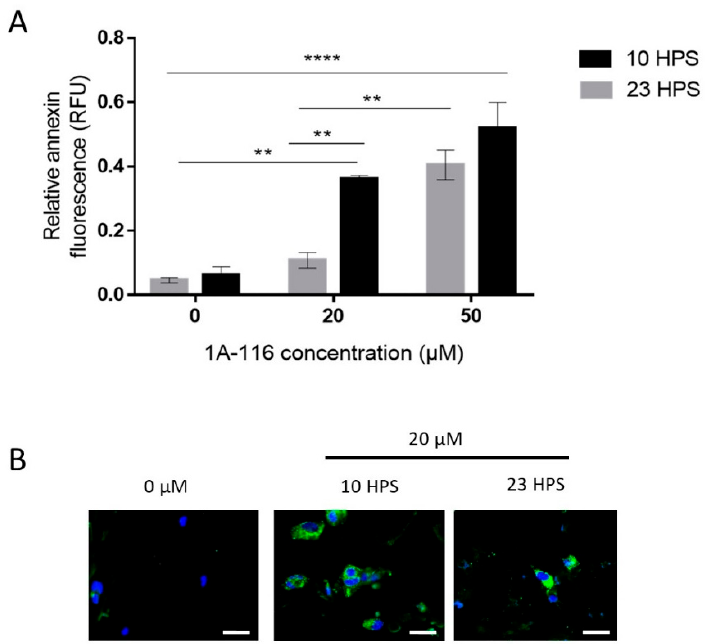
Figure 3. Apoptosis induction by 1A-116 is higher at 10 HPS in LN229 cells. Annexin V staining was used to measure early apoptosis in LN229 cultures 6 h after the addition of vehicle, 20 µ M, or 50 µ M of 1A-116. Fluorescence intensity was measured in a Cytation 5 system and DAPI staining was used to relativize the number of cells in each well. ( A ) Relative early apoptosis values were obtained for three independent experiments (N = 3) and were compared between treatments at 10 HPS and 23 HPS. Significantly larger values were observed when the treatment was applied at 10 HPS (two-way ANOVA, for factor HPS p < 0.01, factor Concentration p < 0.001, interaction p < 0.05. Multiple comparisons Tukey´s tests: 0 μ M 23 HPS vs. 20 μ M 10 HPS: ** p < 0.01, 0 μ M 10 HPS vs. 20 μ M 10